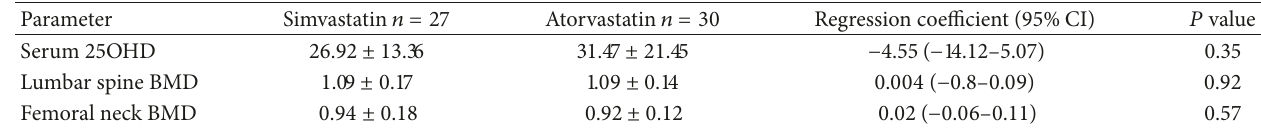
Table 3: Results of serum 25-hydroxyvitamin D, lumbar spine BMD, and femoral neck BMD in the simvastatin and atorvastatin groups. CI: co nfidence interval; 25OHD: 25-hydroxyvitamin D; BMD: bone mineral density.